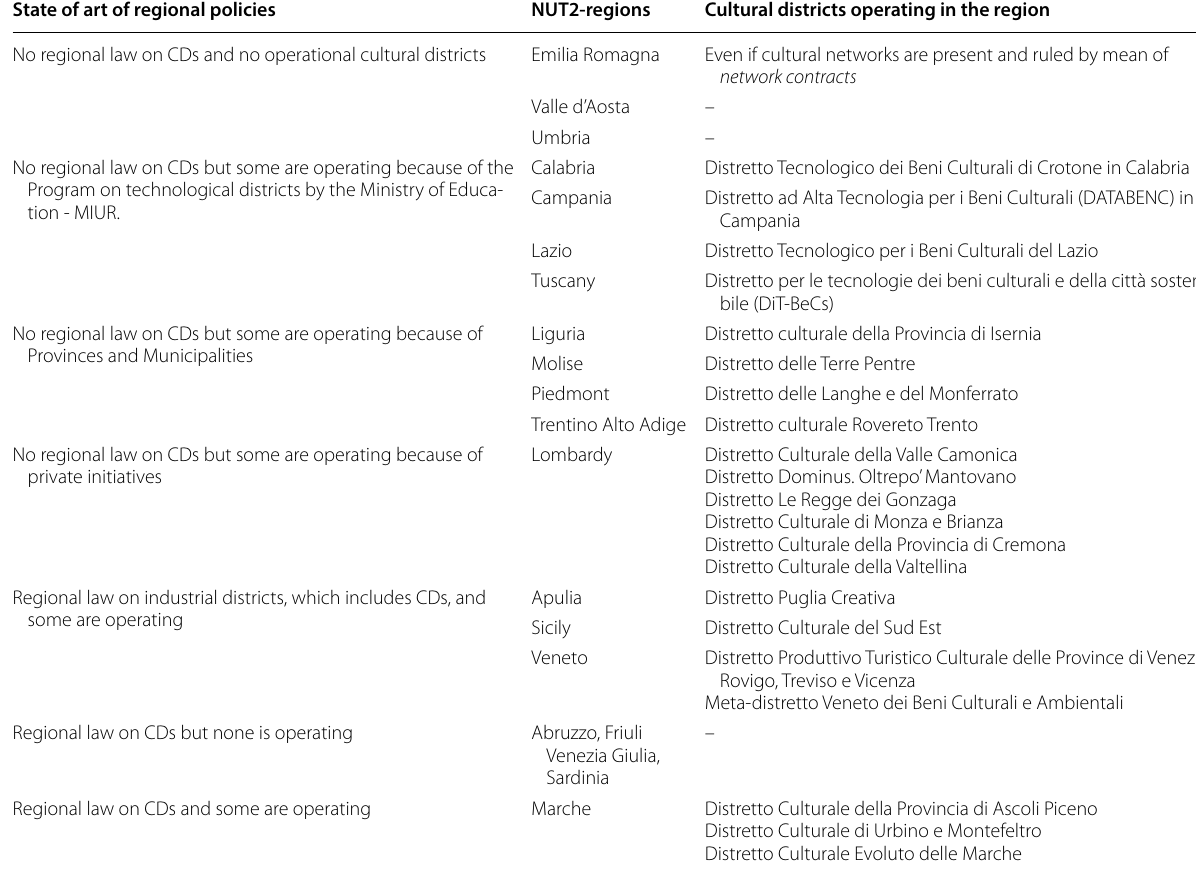
Table 4 Regional policies for cultural districts (CDs) and cultural districts operating in Italian regions. Source: elaboration of the authors on Ponzini et al. (2014), Nuccio and Ponzini (2017), Usai (2016a,